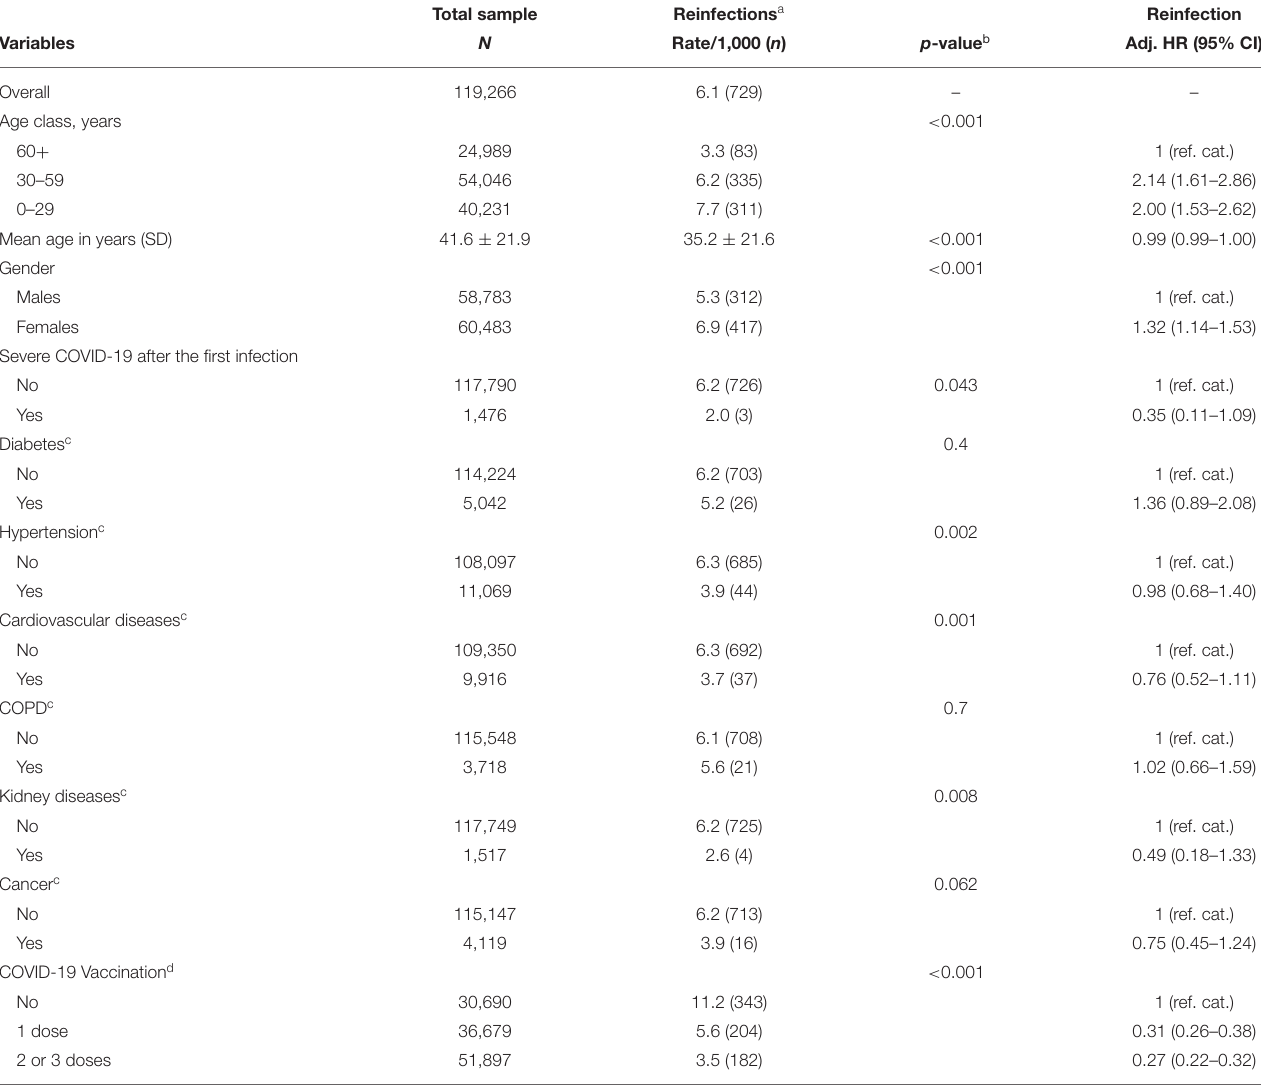
TABLE 2 | SARS-CoV-2 reinfections, overall and by selected